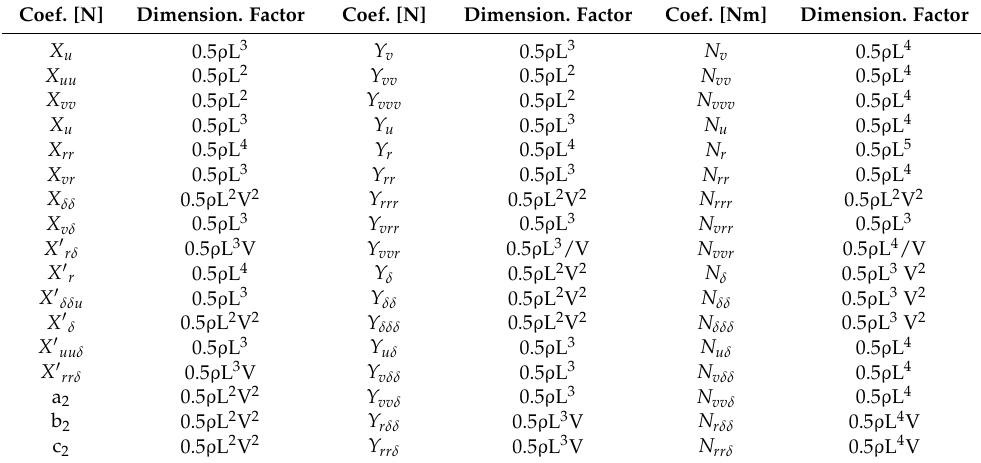
Table 4. Dimensional conversion